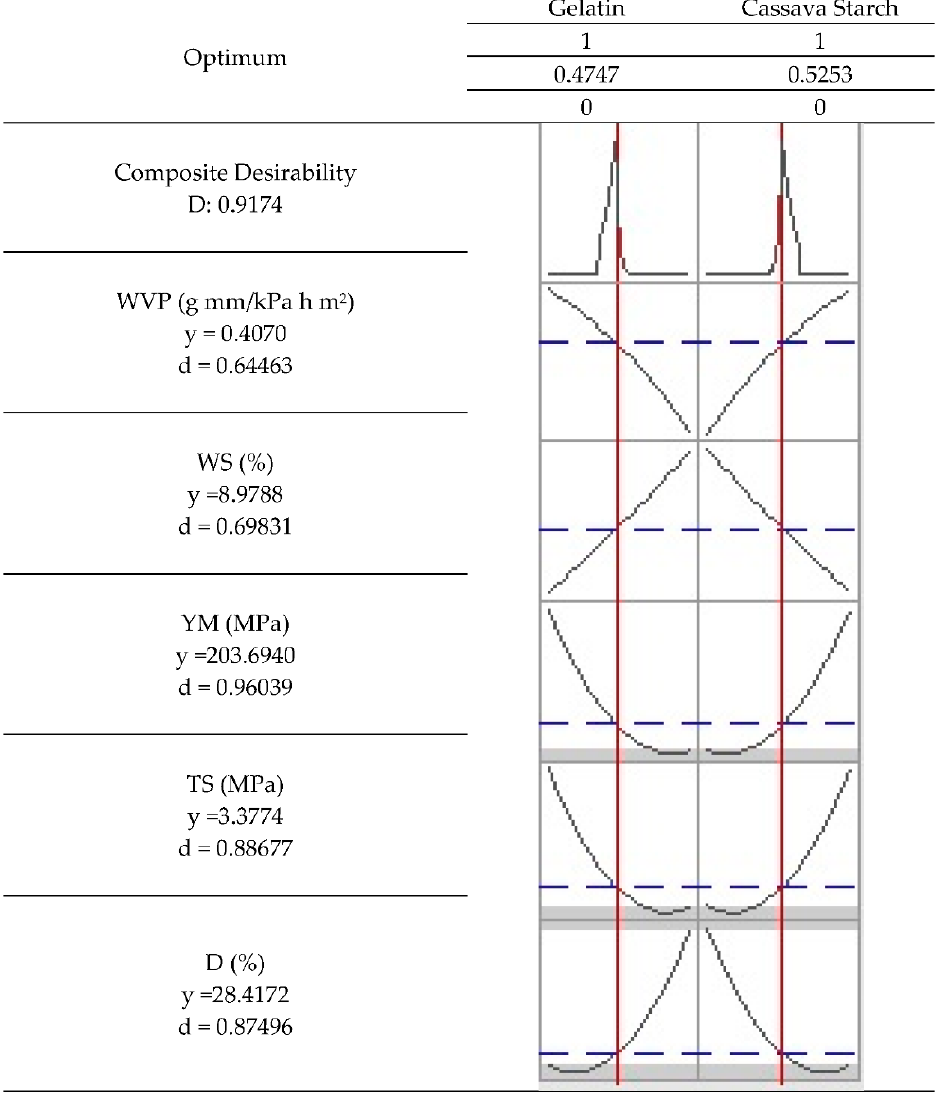
Figure 5. Simultaneous optimization of the variables in the cassava starch/gelatin films.